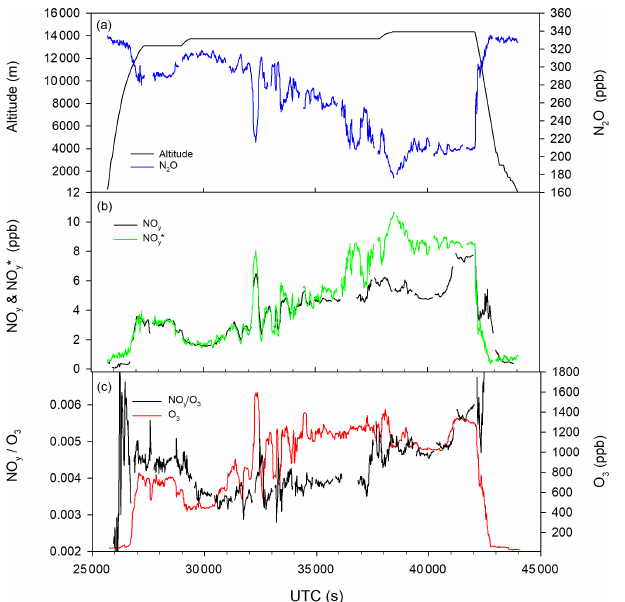
Figure 5. PGS flight 19 on 13 March 2016. (a) Altitude and N 2 O; (b) NO y (observed) and NO ∗ y (calculated); (c) NO y / O 3 ra- tio and O 3 .